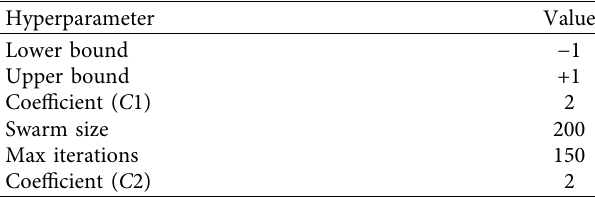
Table 6: Particle swarm optimization hyperparameters.